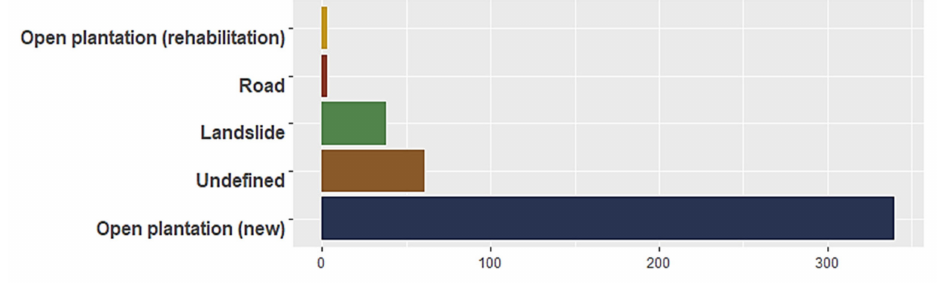
Figure 8. Forest change characterization based on satellite-based